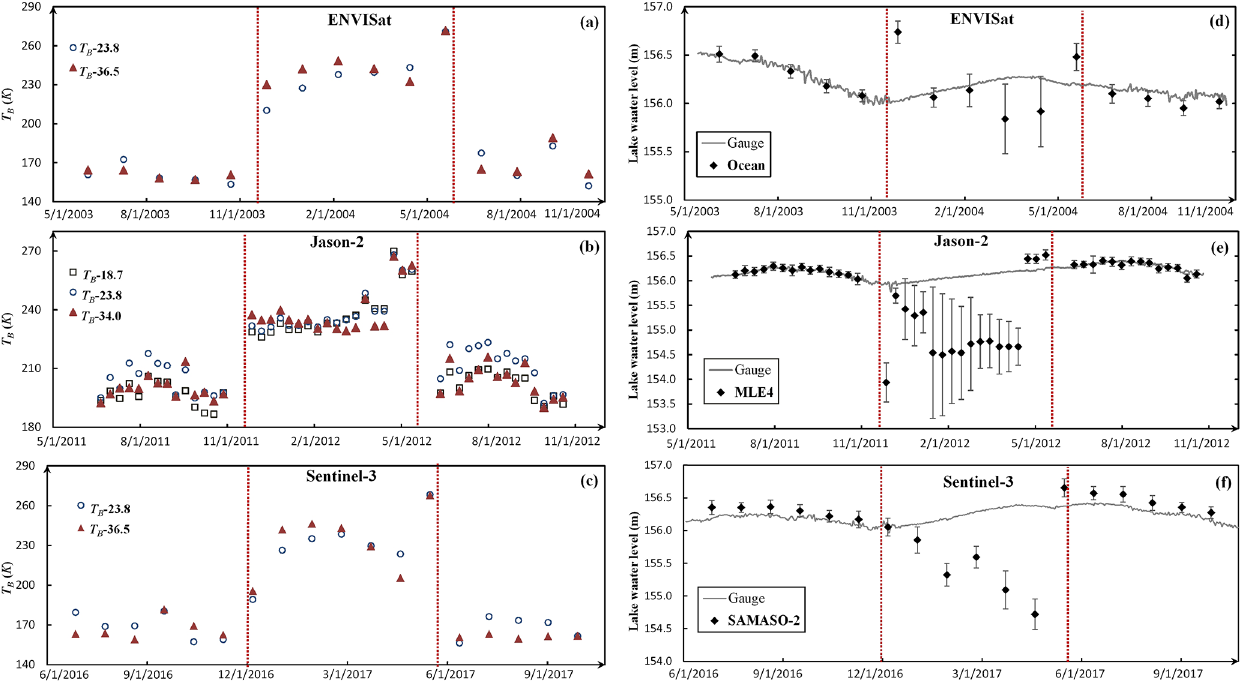
Figure 3. Time series of mean brightness temperature ( T B ) and lake level estimates produced by ENVISAT, Jason-2, and Sentinel-3 over Great Slave Lake in the winter. (a) T B in the 2003–2004 winter, (b) T B in the 2011–2012 winter, (c) T B in the 2016–2017 winter, (d) lake level estimate in the 2003–2004 winter, (e) lake level estimates in the 2011–2012 winter, and (f) lake level estimates in 2016–2017